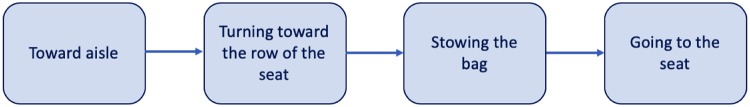
State diagram of passengers during the boarding procedure.